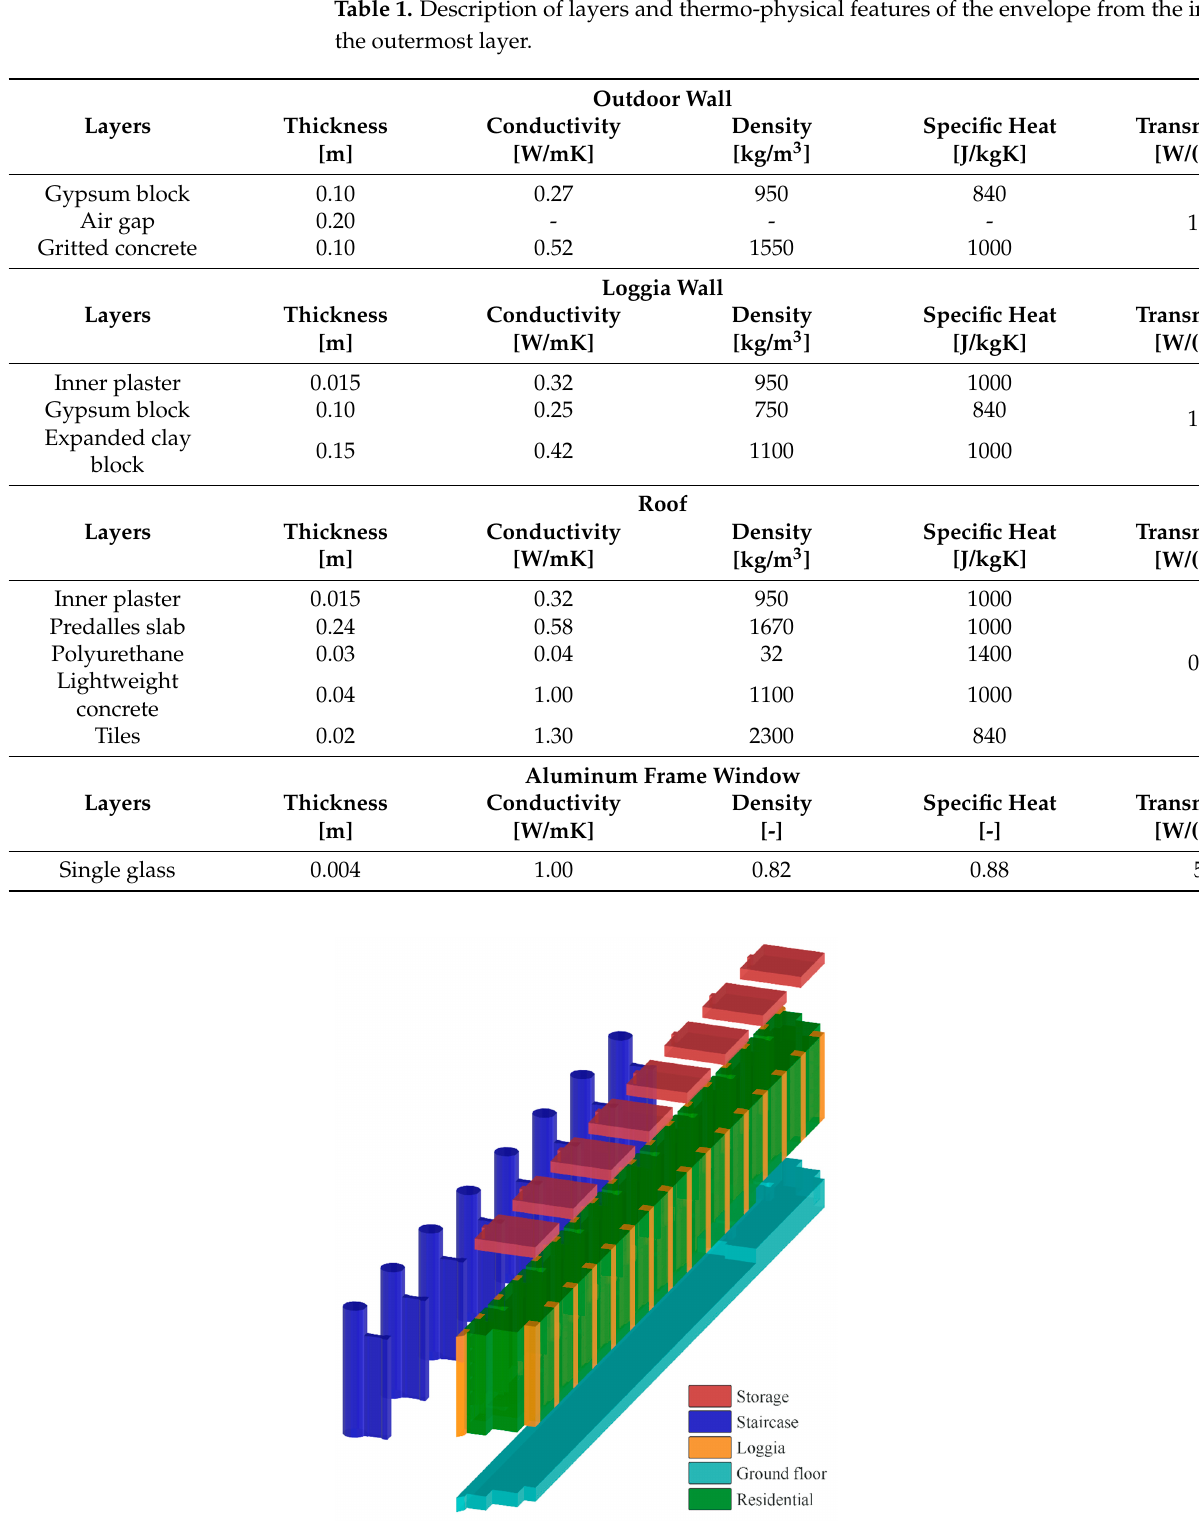
Figure 4. Exploded view of thermal zones of the energy model.